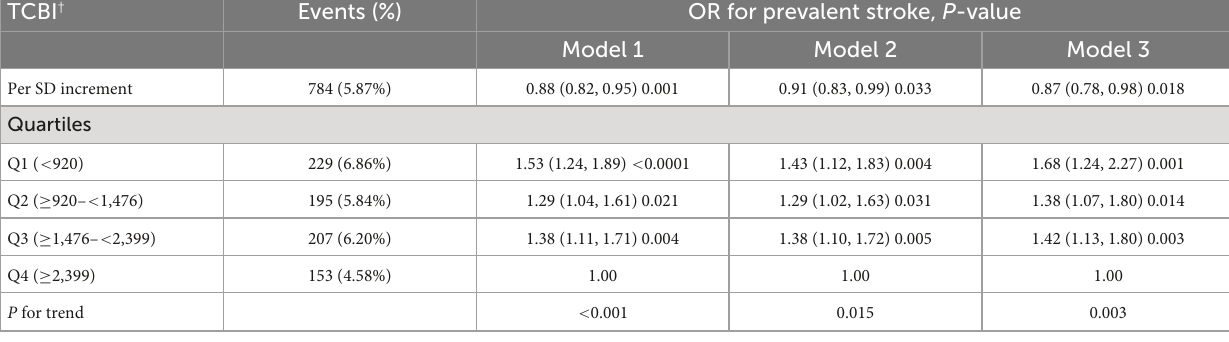
TABLE 2 Association of triglycerides, total cholesterol, and body weight index (TCBI) with stroke.